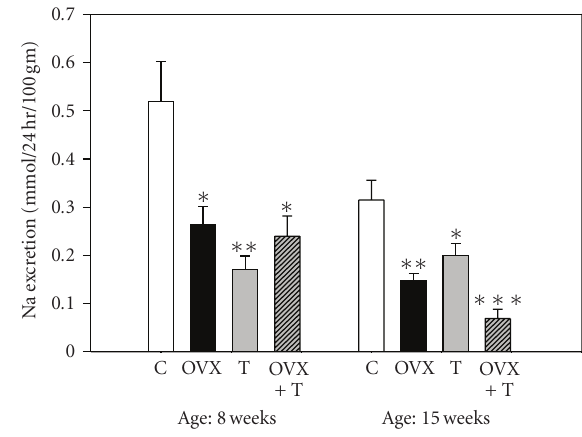
Figure 1: Systolic blood pressure of female SHR by treatment and time (means ± SEM). Two-way repeated measures ANOVA: treatment- F = 19 . 6, df = 3, P < . 001, age- F = 14 . 7, df = 9, P < . 001, interaction- F = 2 . 3, df = 27, P < . 001. Solid circles: controls ( n = 8), solid triangles: ovarectomy-OVX ( n = 6), open circles: testosterone treated-T ( n = 6), open triangles: ovarectomy and testosterone treatment-OVX+T ( n = 7).